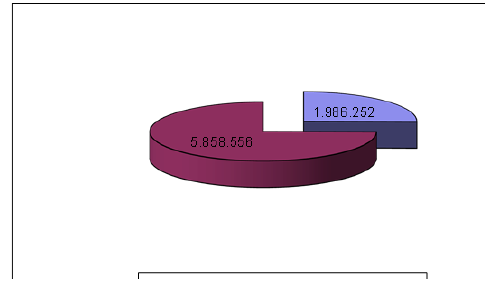
Figure 8: Preference for Sponsor’s Brand in